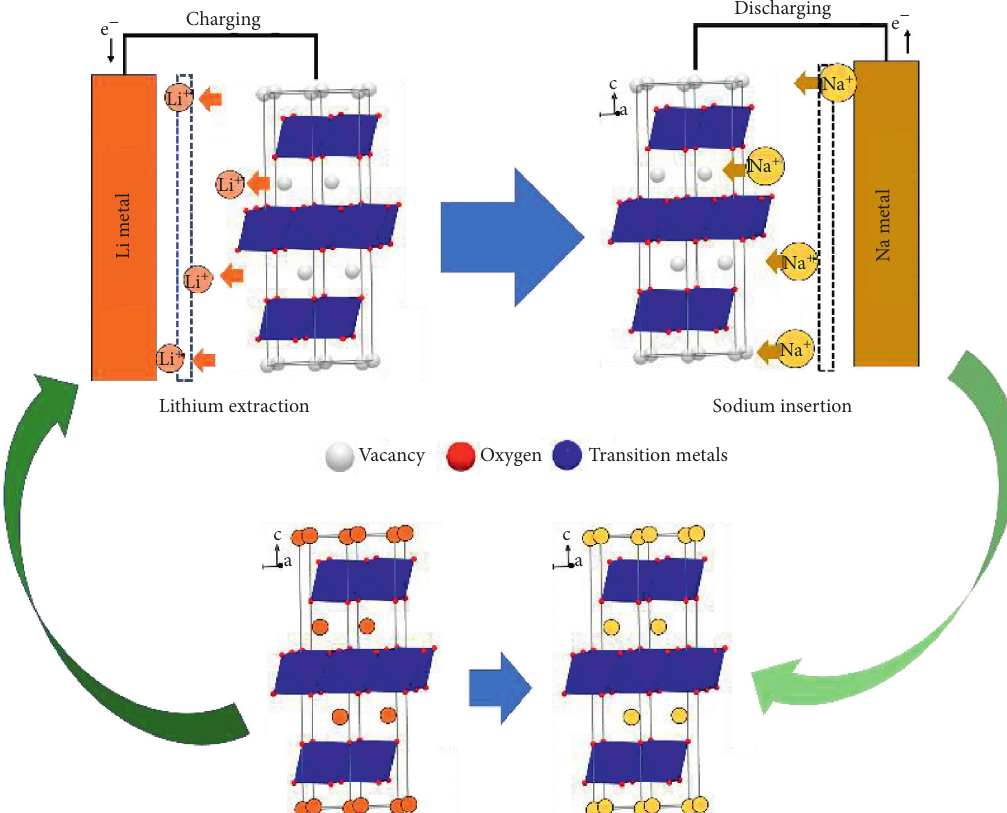
Figure 1: Scheme of the electrochemical ion-exchange process to prepare a new sodium insertion compound from a lithium insertion compound. Lithium-ions extracted from LiNMC crystal structure during charging in Li-half-cell then sodium-ions intercalated to the structure during discharging in